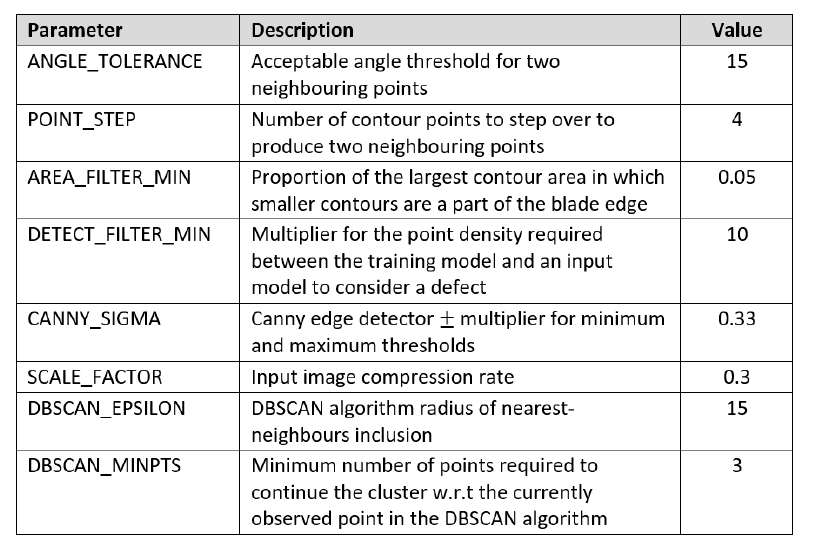
Figure 16. Algorithm parameters.